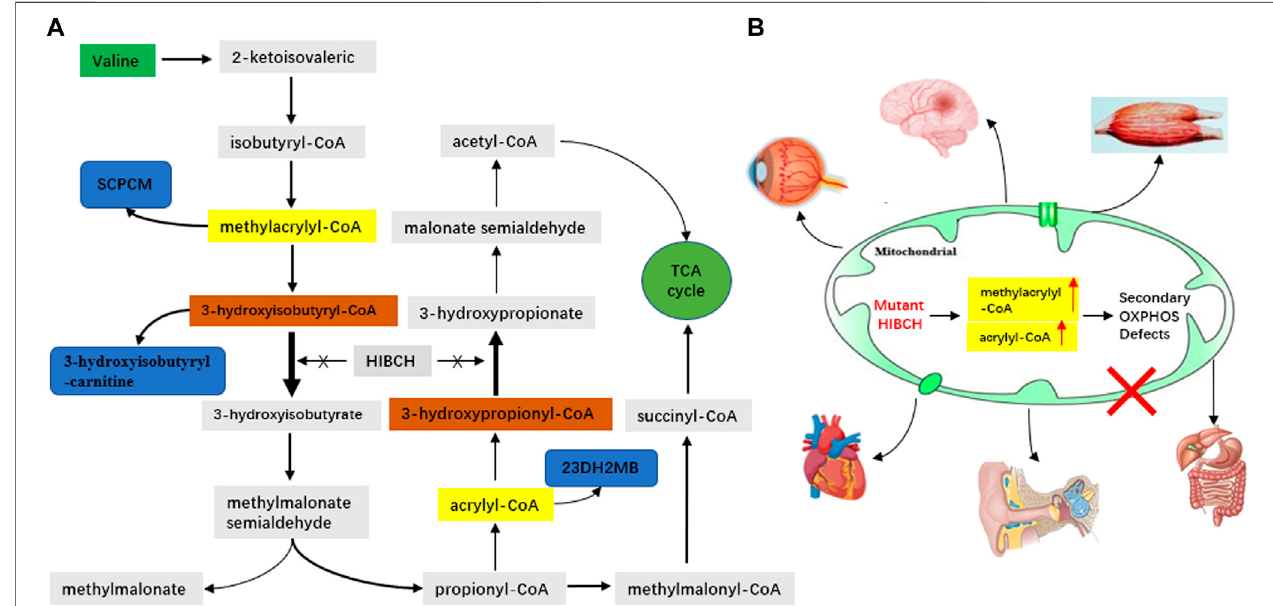
FIGURE 1 | Schematic representation of the valine metabolic pathway involved in HIBCH (A) , and mechanism of HIBCH de fi ciency with the resulting clinical phenotypes (B) . SCPCM, S-(2-caboxypropyl)cysteamine; 23DH2MB, 2,3-dihydroxy-2-methylbutyrate.